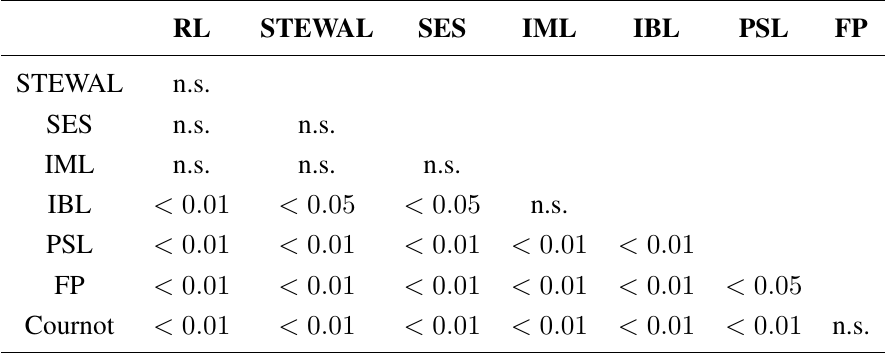
Table 3. P -values in favor of column models, Fisher-Pitman permutation test for paired